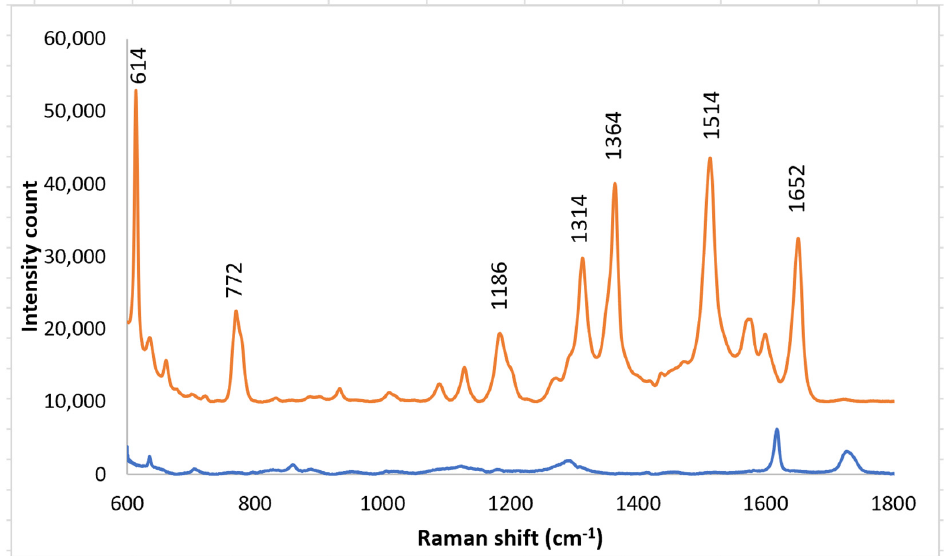
Figure 7. Top trace, Raman spectrum of 1 mm R6G after drop casting silver nano-sphere suspension on imprinted PETE-1. Bottom trace, Background spectra obtained after drop casting silver nano- sphere suspension on an imprinted PETE-1 SERS with no R6G present.